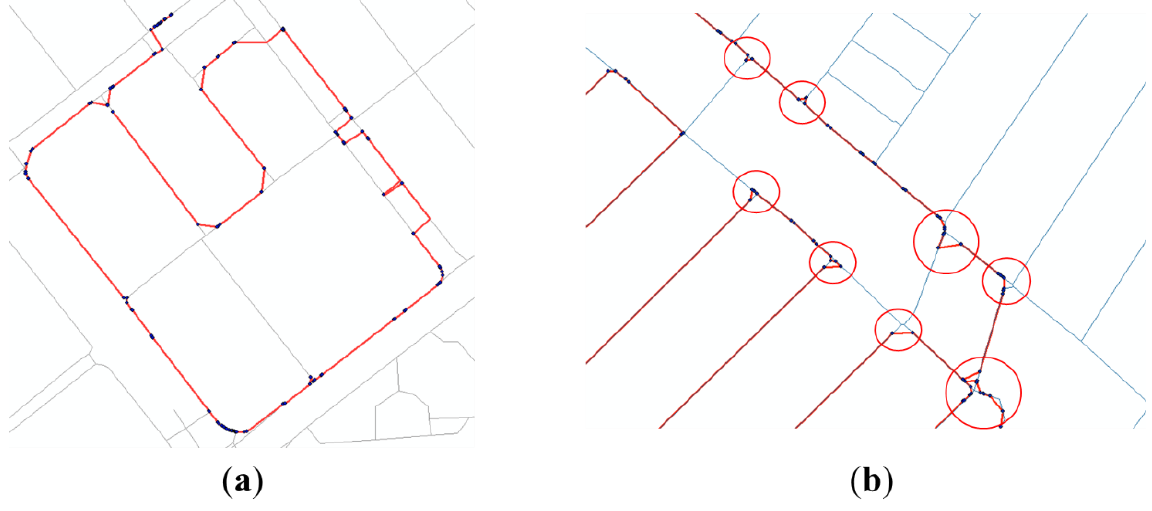
Figure 11. Error cases in initial solution(thin lines refer to existing PND, and thick lines refer to the initial solution of the significant points): ( a ) Example of errors on dual-lined segments; ( b ) Examples of errors near the intersections.